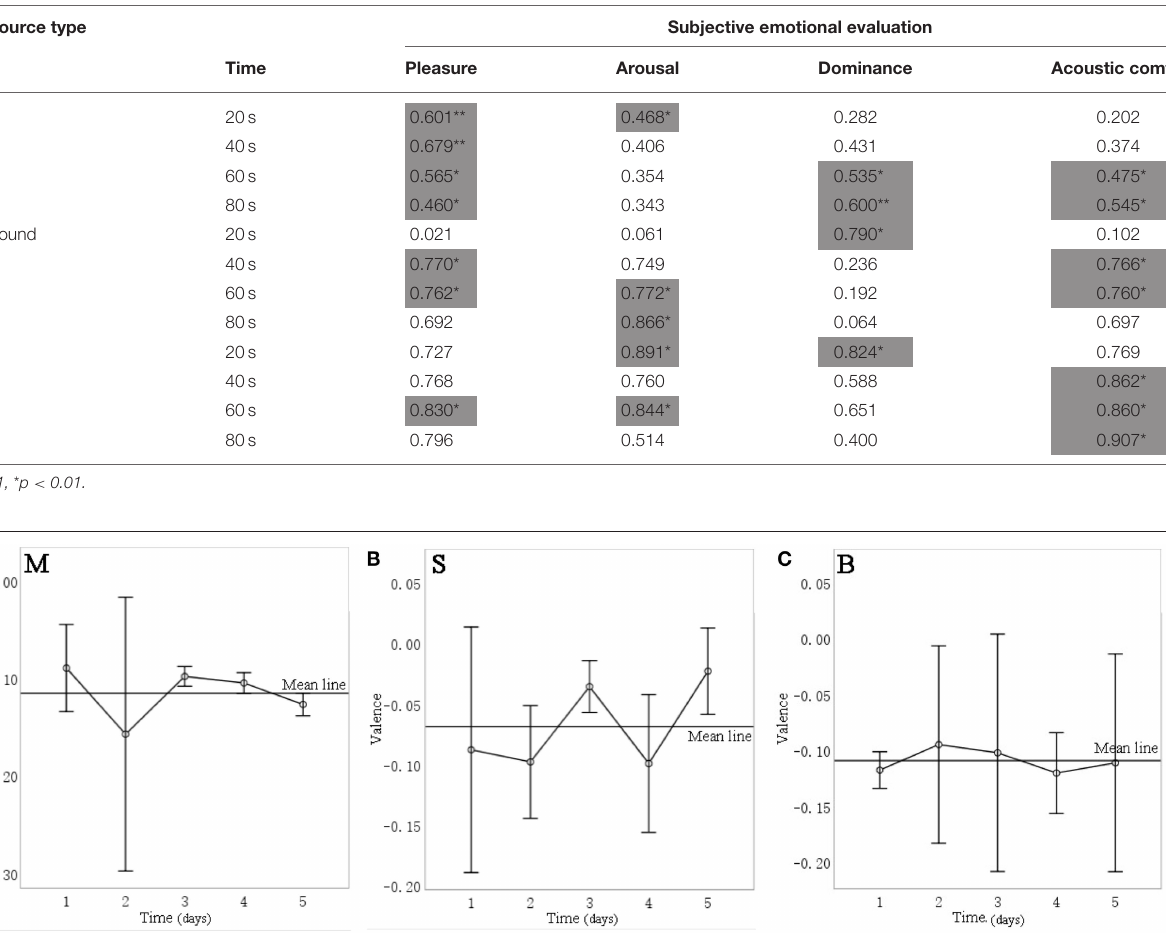
from 0460 to 0.679) is significantly correlated with valence at all four-time points. Dominance (r ranging from 0.282 to